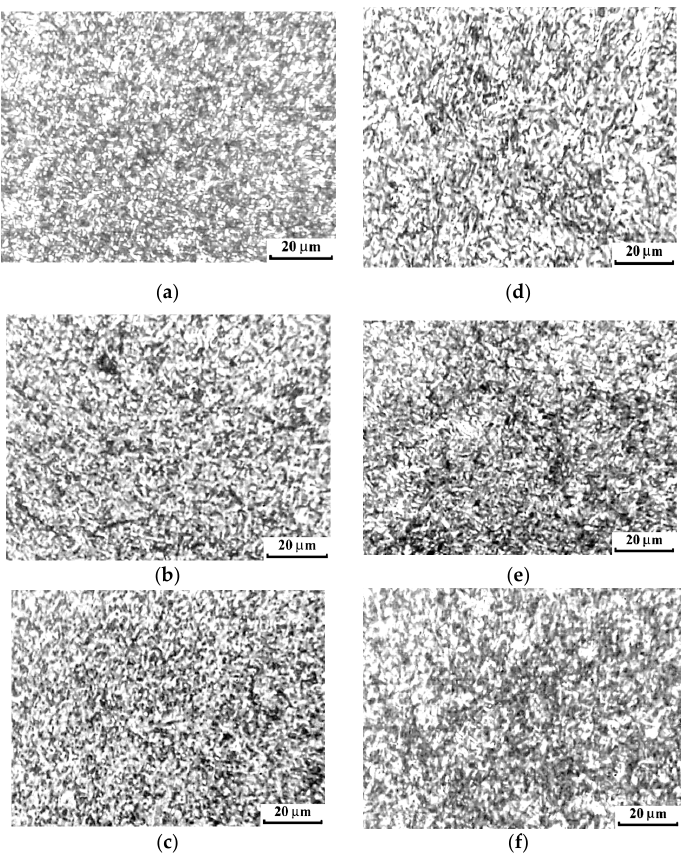
Figure 6. Microstructure of Ti-Al-Mo-V alloy at the ∅ 16 → ∅ 10 mm transition. From top to bottom: samples 6, 8, and 10 (see Figure 1); ( a – c ) surface structure; ( d – f ) structure at the central part of the rod.